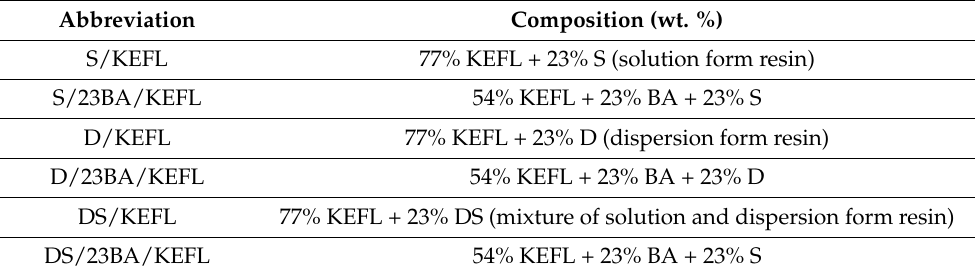
Table 3. Abbreviation and composition (wt. %) of the composites.